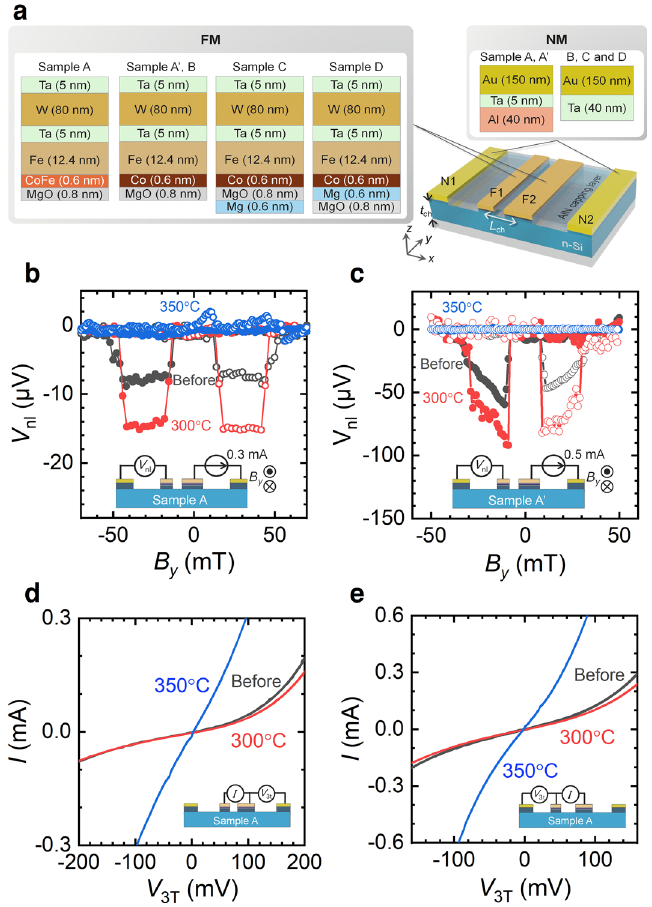
B y , for sample A before annealing (black) and after annealing at 300 °C (red) and 350 °C (blue), obtained by the NL4T method. The channel length L ch was 2.0 µm, and the channel thickness t was 80 nm. The widths of F1 and F2 were 0.2 and 1.2 µm, respectively. ( c ) Spin accumulation signals of sample A’ before annealing (black) and after annealing at 300 °C (red) and 350 °C (blue), obtained by the NL4T method. The channel length L ch was 1.6 µm, and the channel thickness t was 100 nm. The widths of F1 and F2 were 0.5 and 2.0 µm, respectively. ( d , e ) I – V characteristics of ( d ) F1 and ( e ) F2 before annealing (black) and after annealing at 300 °C (red) and 350 °C (blue) for sample